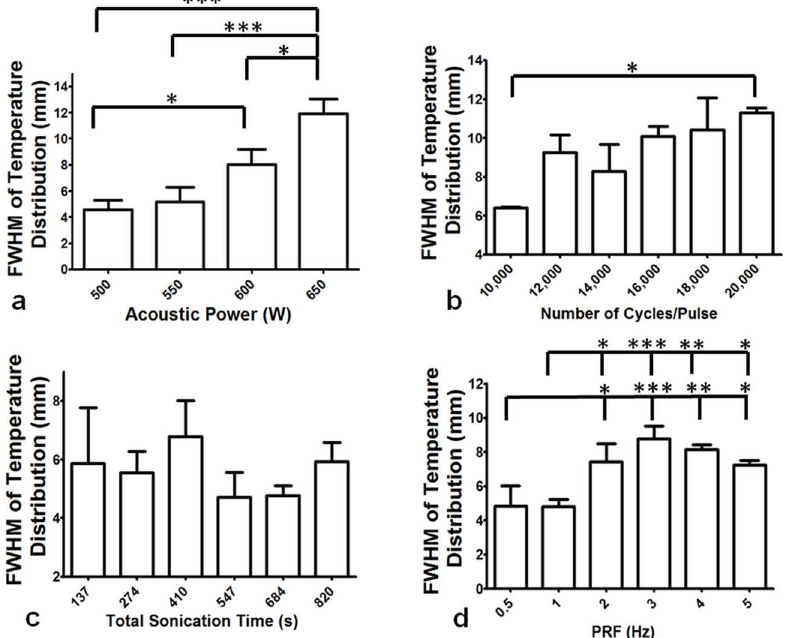
Fig 6. Full Width at Half Maximum (FWHM) was calculated as a measureof temperature distribution at the end of each sonication in tissue-mimicking phantoms. a . Varying acoustic power, significant differences in FWHM were found between 550 and 650 W, as well as for 600 and 650 W (p (cid:20) 0.05). b . Comparingthe numberof cycles/pulse, significantdifferences were found between10,000 cycles/pulse and 20,000cycles/pulse (p = 0.042). Other parameters showedno differences in FHWM. c . Total sonicationwas varied from 137 to 820 seconds and no significantdifference was found in the FWHM betweenany parameters (p > 0.05). d . Varying PRF from 0.5 Hz to 5 Hz resulted in significantdifferences in FWHM between0.5 and 2, 3, 4, and 5 Hz. Similarly,significantdifferences were found between1 and 2, 3, 4, and 5 Hz (p (cid:20) 0.05). No significantdifferences were found betweenany other